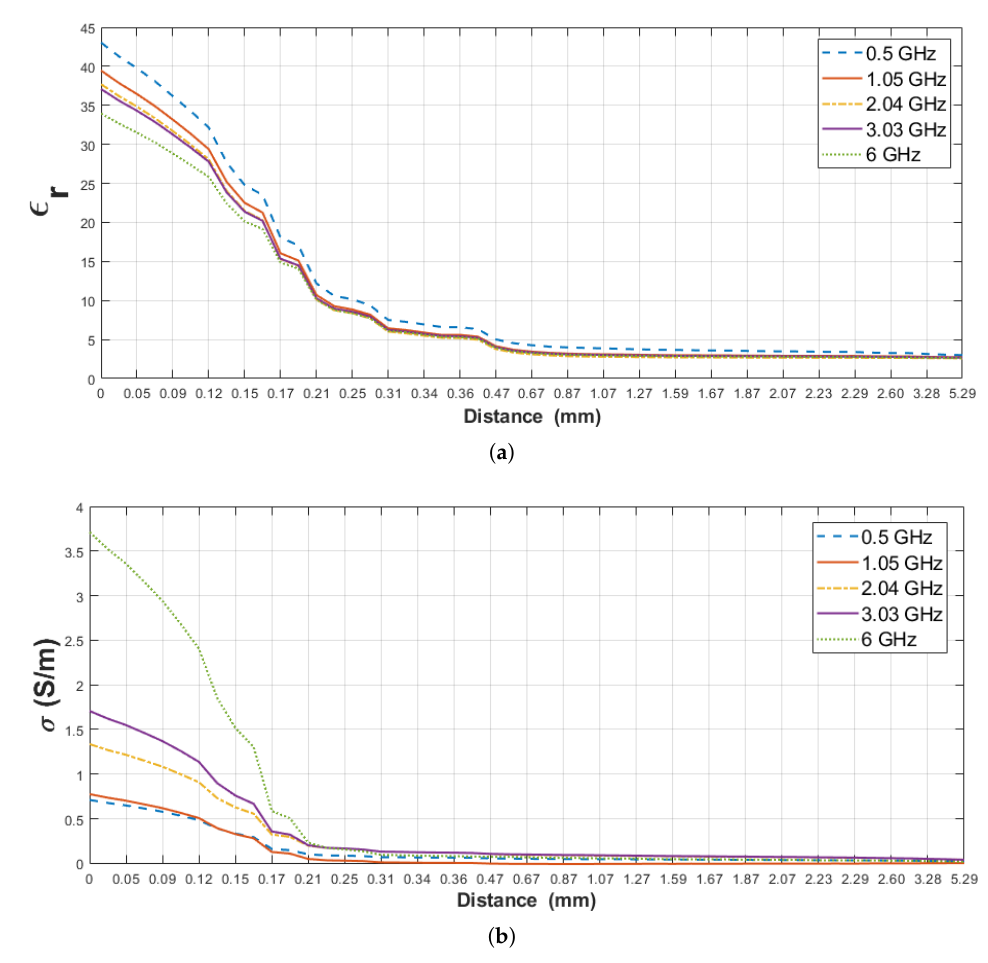
Figure 9. Measured dielectric properties of the double-layered rat breast tissue-olive oil configuration: ( a ) Relative permittivity, ( b ) conductivity as a function of probe tip distance from first layer (D n ) at 0.5, 1.05, 2.04, 3.03 and 6 GHz frequencies. Table 4. The relative permittivity and conductivity of pure materials (rat breast tissue and olive oil) at five frequency